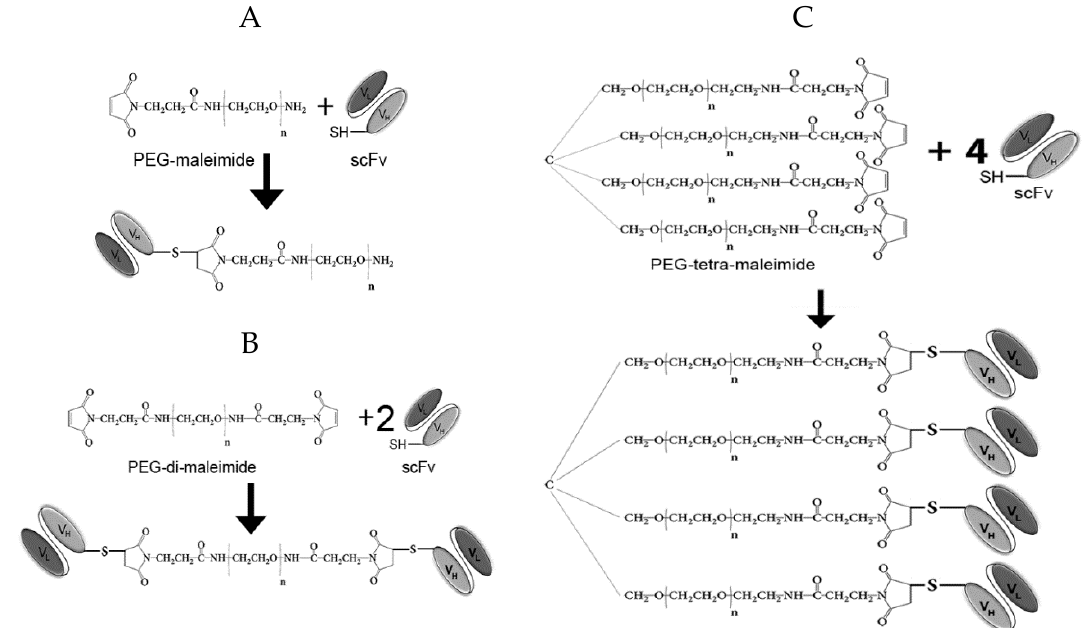
Figure 2. Schematic representation of pegylation reactions. ( A ) Generation of scFv-PEG conjugates using PEG-maleimide. ( B ) Generation of di-scFv-PEG multimers using PEG-di-maleimide. ( C ) Generation of tetra-scFv-PEG multimers using PEG-tetra-maleimide.